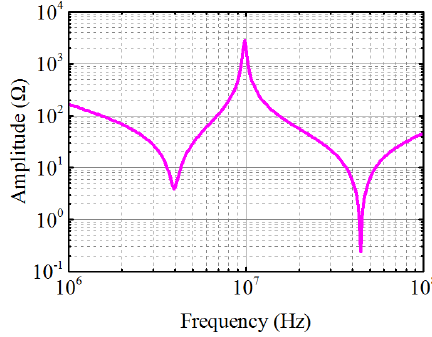
Figure 20. Frequency-domain characteristics of the CM circuit in HF range.